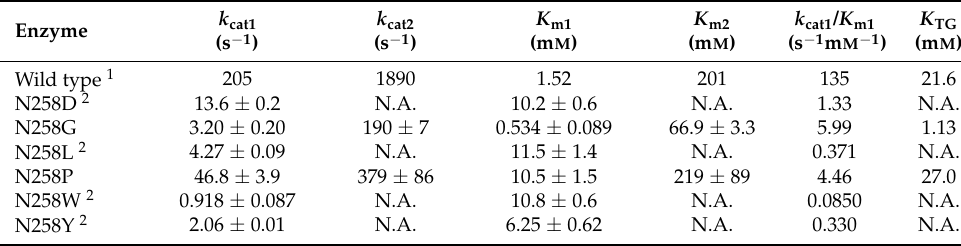
Table 3. Kinetic parameters of BspAG13_31A Asn258 variants to G2.